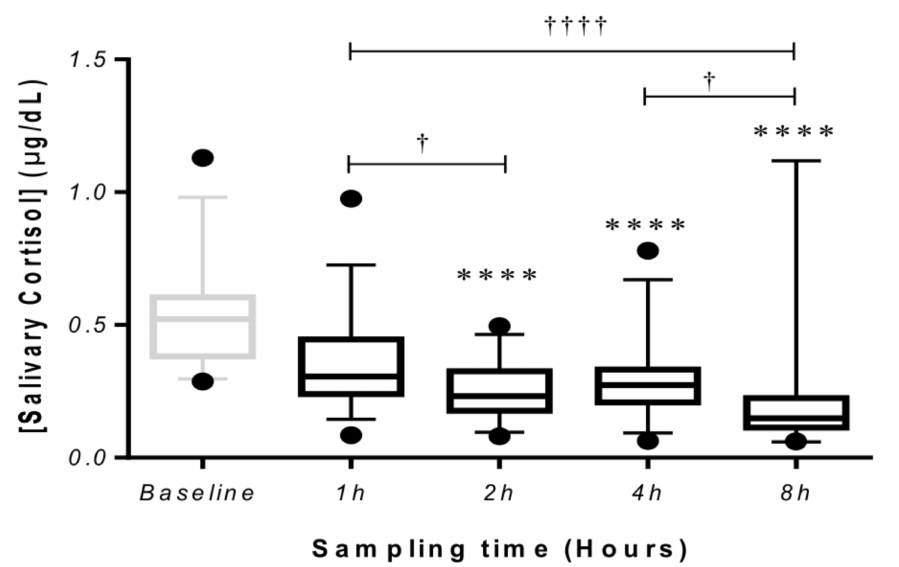
Figure 4. Salivary cortisol changes box plots. The boxes (25–75th percentiles) show the median concentrations of salivary marker (line within the box) and whisker plots represent the minimum (5th percentiles) and maximum values (95th percentiles). **** p < 0.0001 compared to baseline values. † p < 0.05, and †††† p < 0.0001 comparing between different sampling times. N =